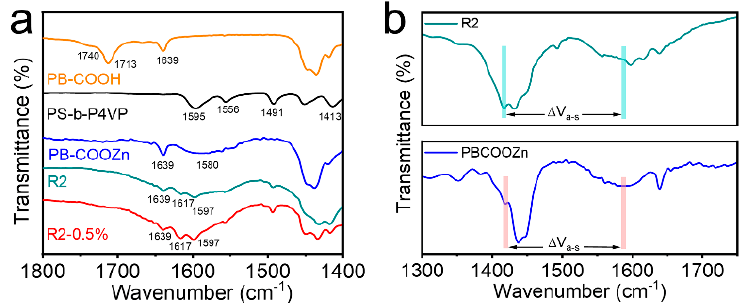
Figure 3. ( a ) FTIR spectra for component polymers and their blends. ( b ) The frequency separations ( ∆ v a-s ) between the symmetric and asymmetric stretching modes of COO − in R2 and PBCOOZn.